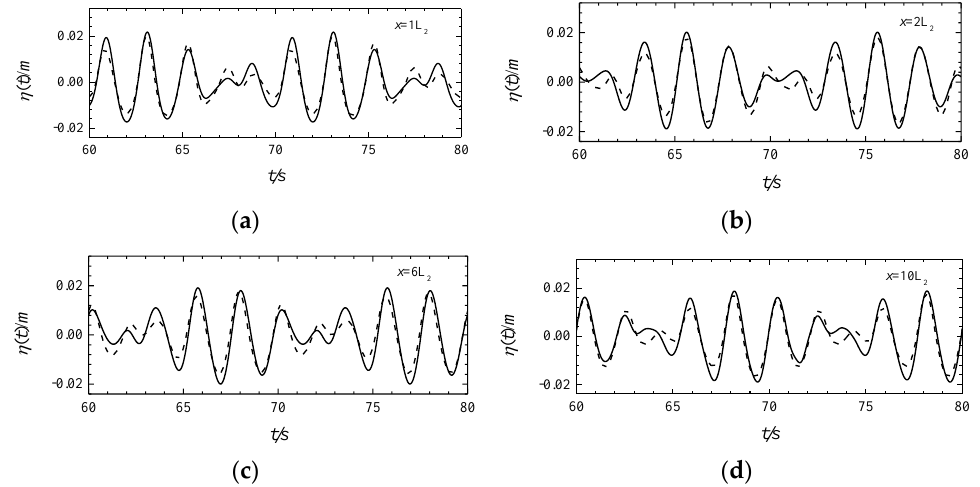
Figure 7. Comparison of wavefronts at X = 1L 2 ( a ), X = 2L 2 ( b ), X = 6L 2 ( c ), X = 10L 2 ( d ) in the MIKE 21 BW model (solid line) and the Navier – Stokes model (dashed line) (operating condition C1).